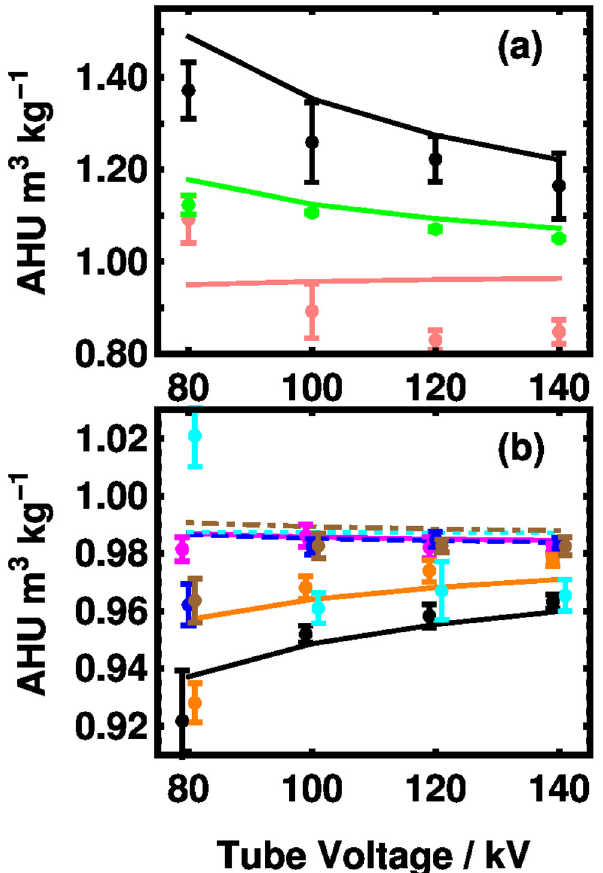
Fig 10. Mass HU potency vs. tube voltage for reference materials from the CIRS Model 62 phantom. [32] The tissue-equivalent materials are: (a) dense bone (black), trabecular bone (green), lung exhaled (salmon) (b) liver (magenta), muscle (blue, dashed), breast (orange), adipose (black) lung inhaled (cyan, dotted), and plastic water (brown, dot dashed). Hounsfield unit data and uncertainties from Ref. [32] have been scaled by the densities. [20] Some data points in (b) have been offset by ± 1 kV for